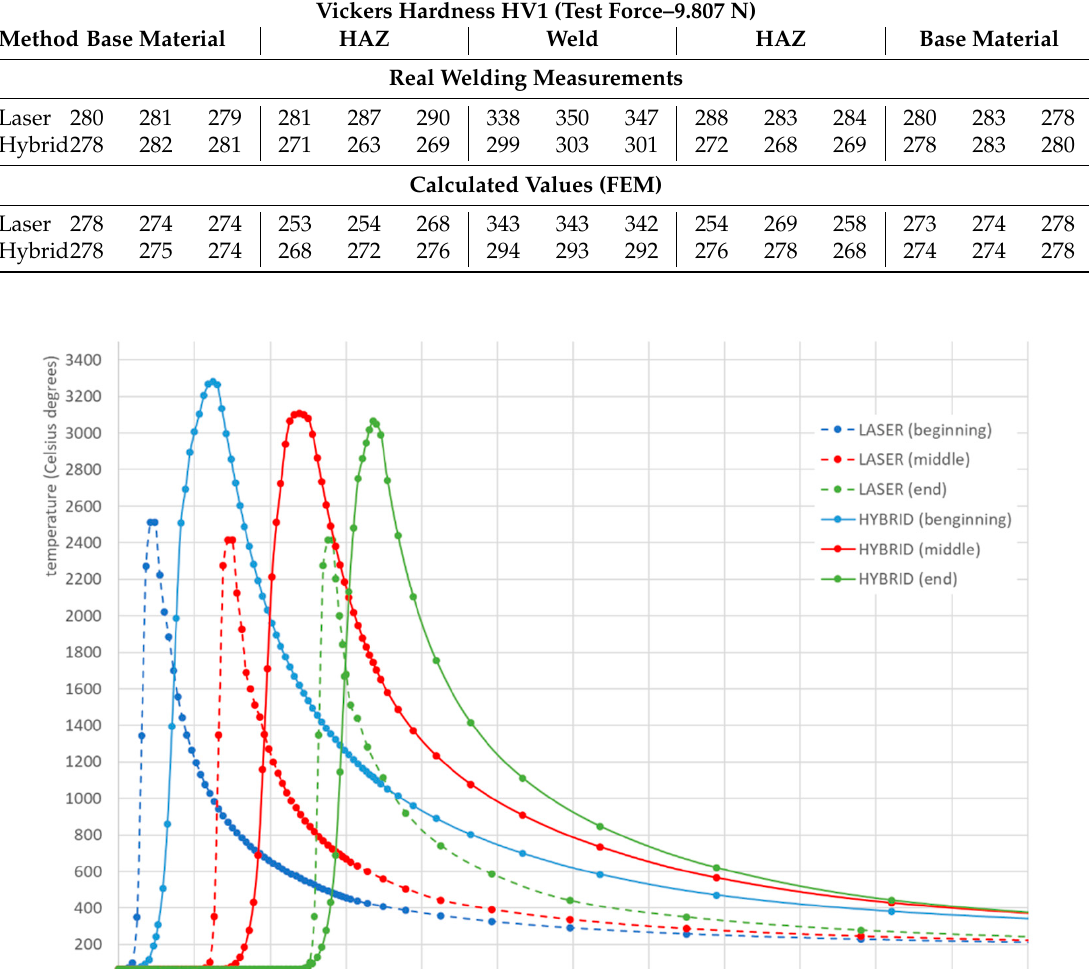
Figure 9. Calculated thermal cycles for laser and hybrid welded S700MC steel T-joints with a thickness of 10 mm.